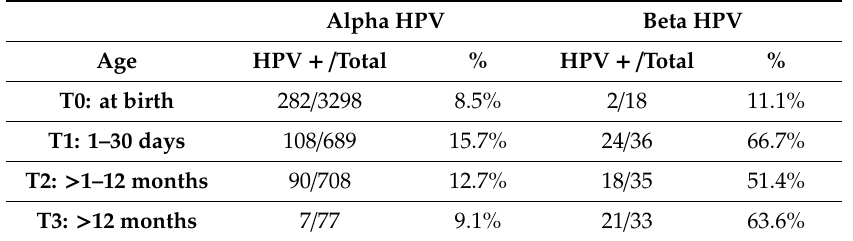
Table 3. Prevalence of alpha and beta HPVs in nasopharyngeal samples of infants at and after birth.